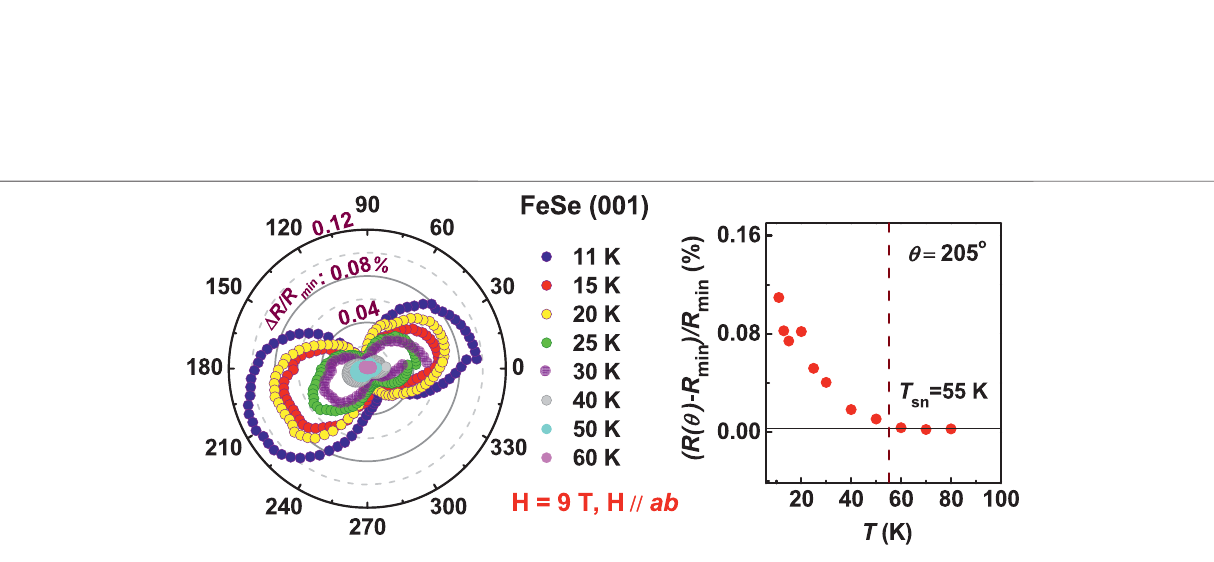
Frontiers in Physics |